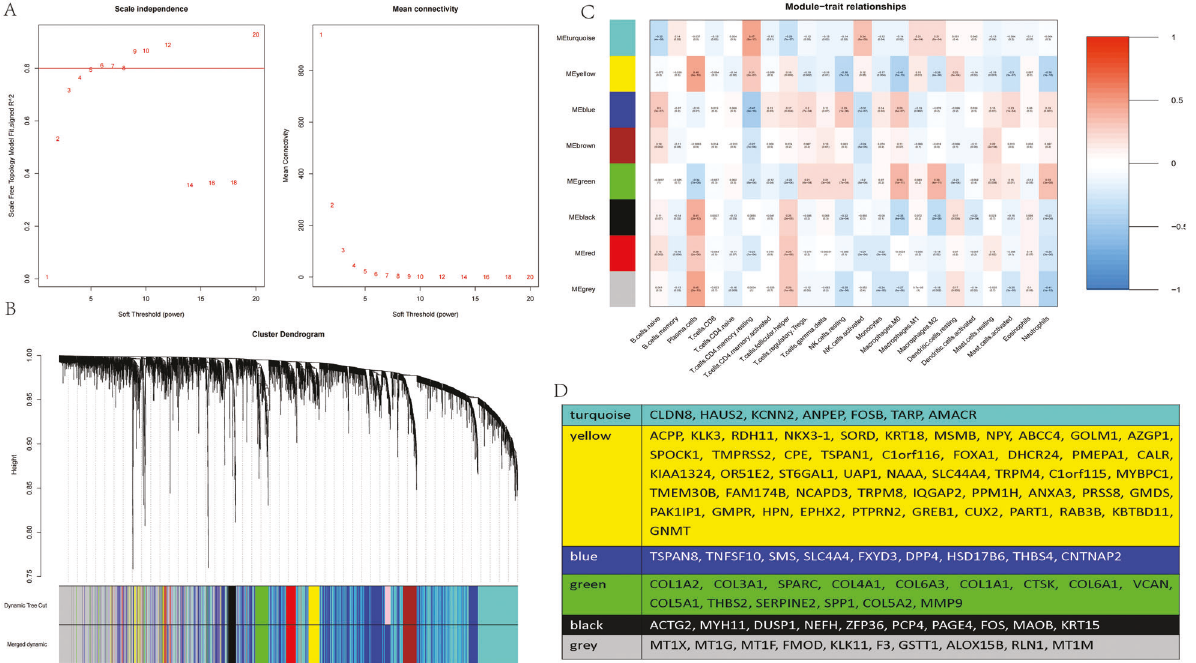
Fig. 6 Correlation between the color modules and immune-in fi ltrating cells. A Determine soft-thresholding power in WGCNA. B Tree diagram of head 5000 genes gathered based on different metrics (1-TOM). C Correlation heat map between modules and immune-in fi ltrating cells. D The corresponding DEGs in each module.